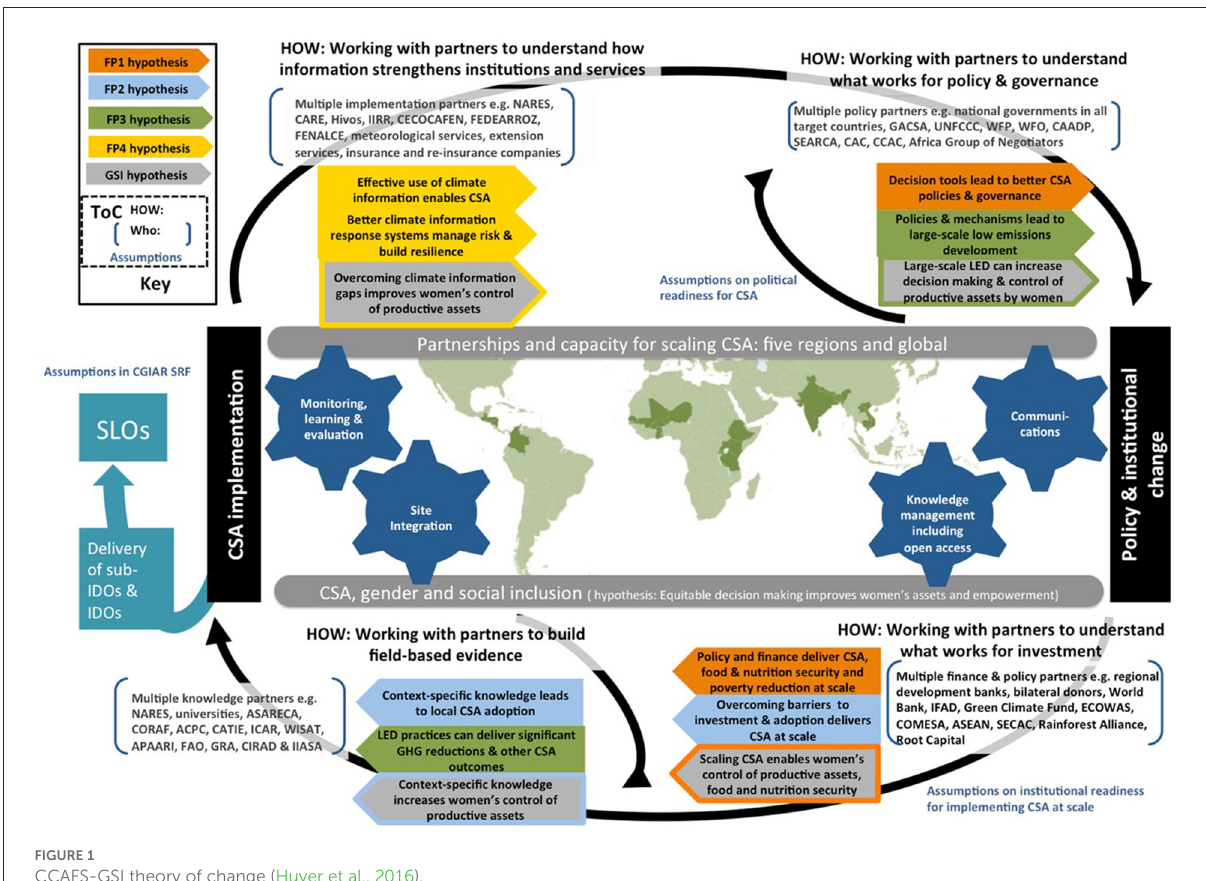
FIGURE1 CCAFS-GSI theory of change (Huyer et al.,